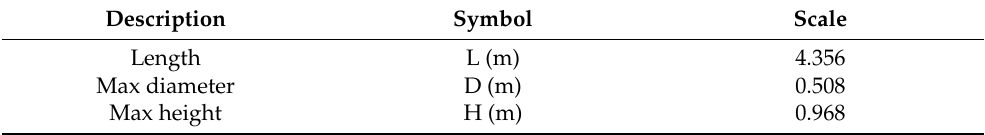
Table 1. SUBOFF scaling model